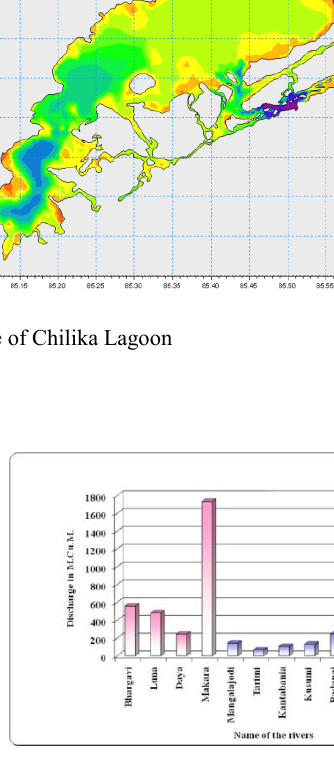
Figure 3. Water discharge into the lagoon during 2009